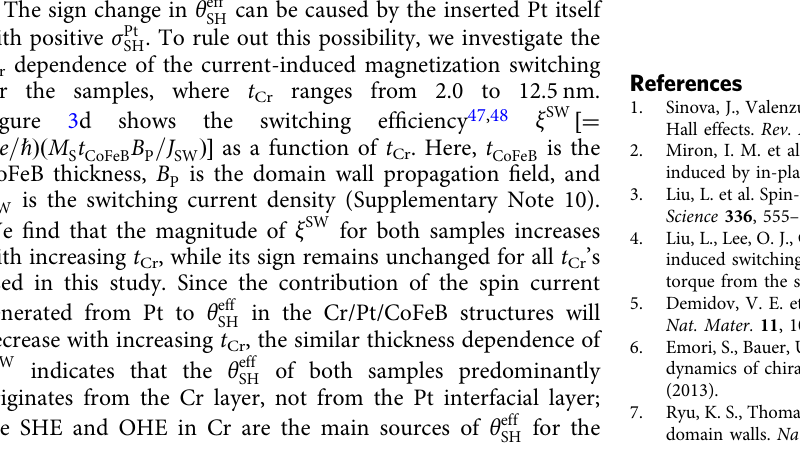
0.6 nm (Supplementary Note 9), where Pt forms a continuous fi lm that effectively converts orbital currents to spin currents. This makes the OHE dominant over the SHE.